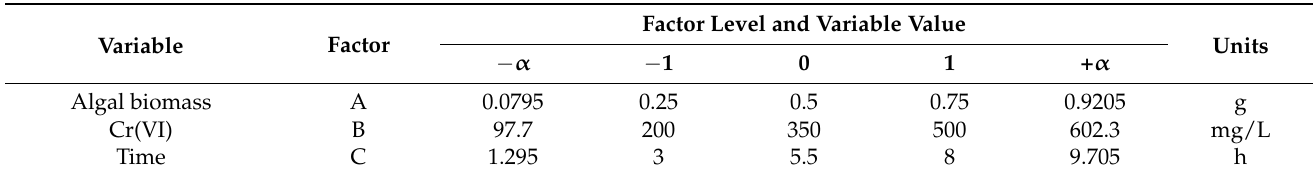
Table 2. Central composite design for the adsorption of Cr in spirulina